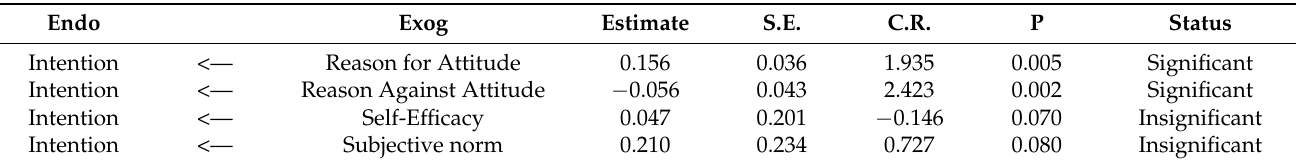
Table 4. Standardized results before COVID-19.